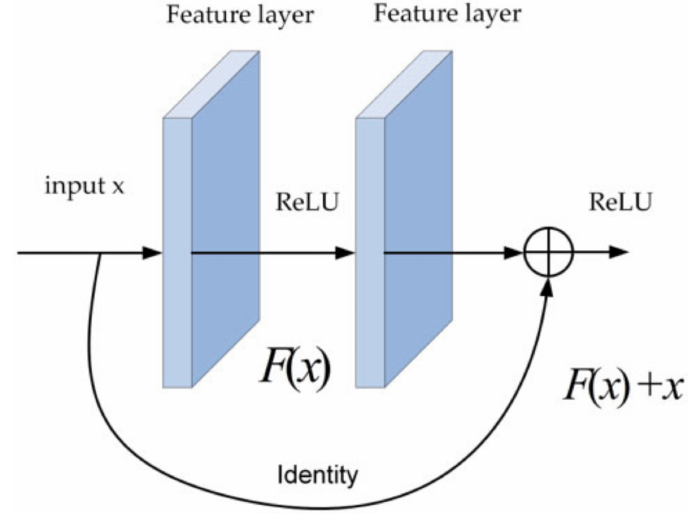
Figure 3. Residual block. Table 2. Backbone network